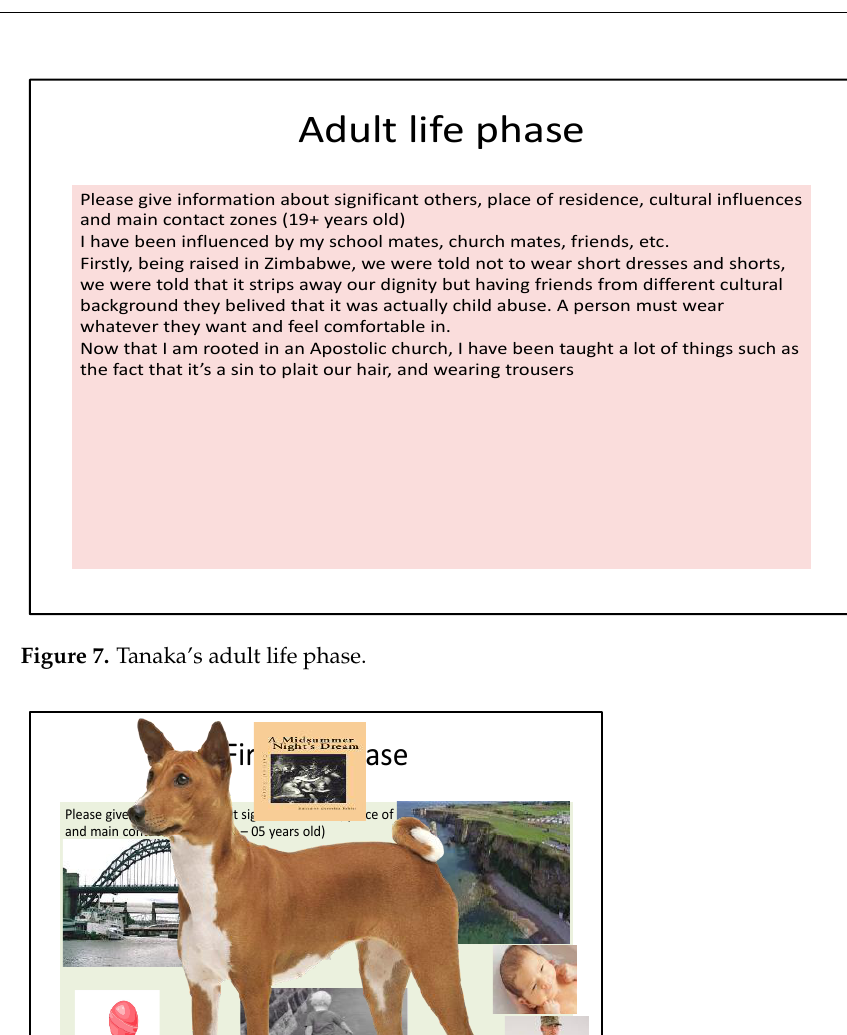
Figure 6. Tanaka’s middle childhood.